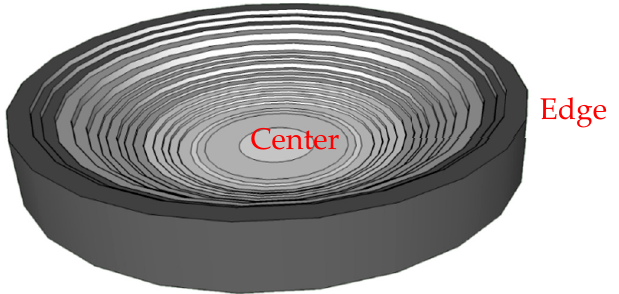
Figure 7. Idealized picture of the variation in thickness of the pattern formed by the evaporated droplet of the polyelectrolyte–surfactant mixture. The thickness of the deposit decreases from the edge (darker region) to the center (lighter region).